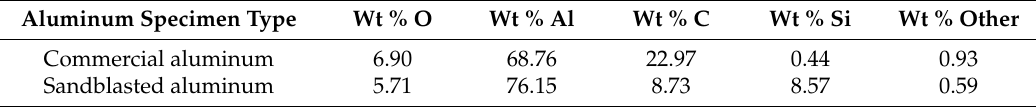
Table 1. EDS analysis of the commercial and sandblasting aluminum substrate surfaces.